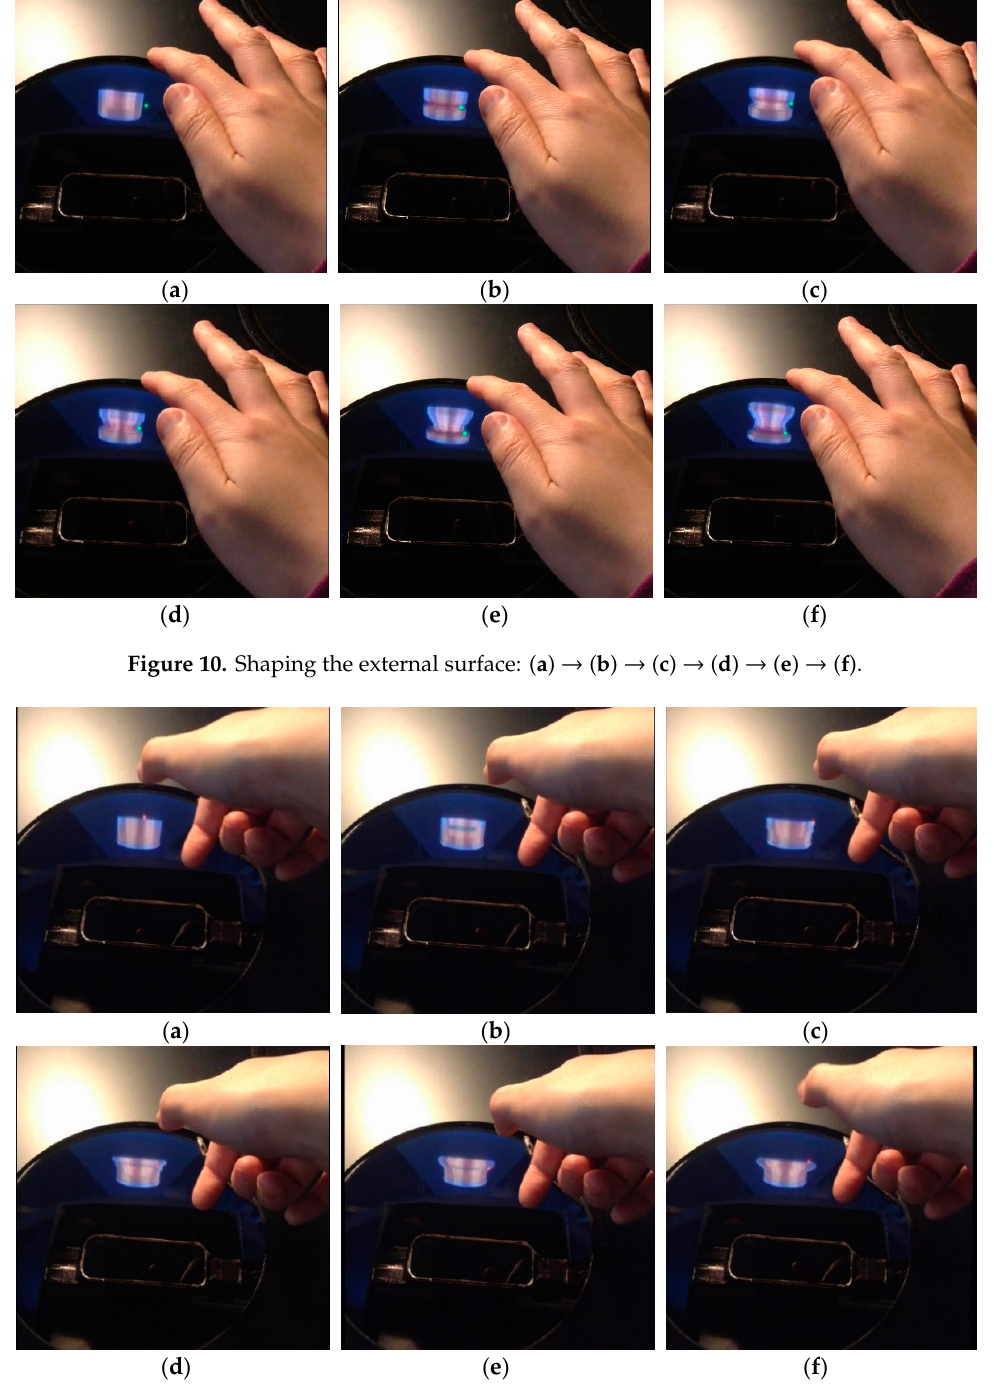
Figure 11. Forming the inner shape: ( a ) → ( b ) → ( c ) → ( d ) → ( e ) → ( f